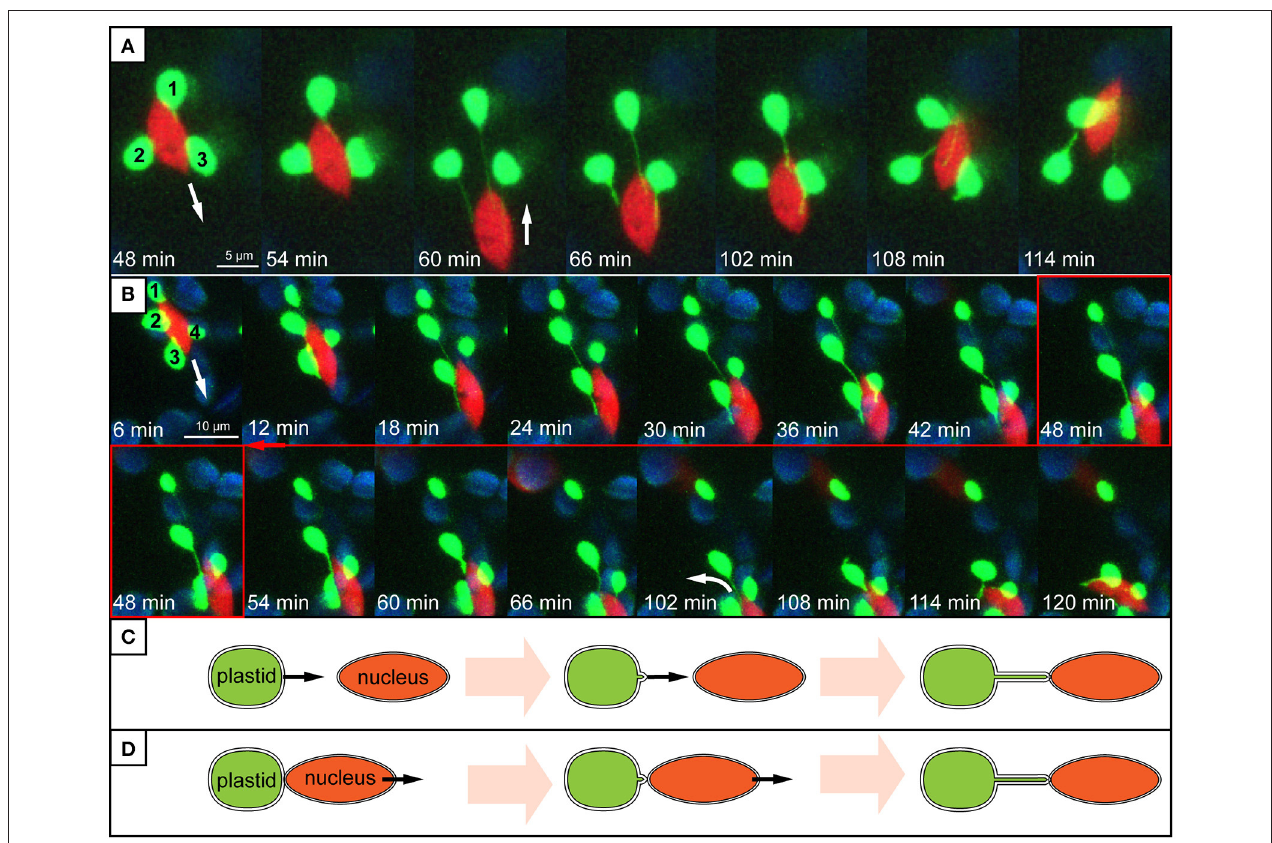
FIGURE 8 | Stromule behavior seems linked to nucleus movement. (A,B) Images are maximum intensity projections along the z-axis, taken from a time series of z-stacks obtained by a confocal laser-scanning microscope. Bright green plastids and red nuclei are organelles of the upper epidermis of an A. thaliana wild-type plant transformed with the pLSU4::pn plasmid (blue channel, chlorophyll fluorescence; red channel, H2B:mCherry fluorescence; green channel, FNRtp:eGFP fluorescence). The white arrows indicate the direction of nuclear movement. Larger, round, blue signals represent underlying mesophyll plastids, where chlorophyll signal is brighter than the FNRtp:eGFP fluorescence signal. (A) Series of images taken from Supplementary Movie 2. It demonstrates how nucleus movement “pulls” stromules out of a group of stationary plastids (1–3) and how stromules shorten, when the nucleus changes its direction. (B) Series of images from Supplementary Movie 3 showing how a nucleus moves away from a group of plastids (1–4). Plastids 2–4 keep their extended stromules and follow the moving nucleus. Plastid 1 stays stationary and looses its stromule after the nucleus moved more than 12 µ m away from it. (C,D) Schematic representation of two possible ways how nucleus associated stromules might be formed. (C) Scenario 1: stromules are formed by plastids residing further away from the nucleus growing toward (“reaching out”) and connecting to the nucleus. (D) Scenario 2: nucleus associated plastids are anchored to the surface of the nucleus and due to nucleus movement a stromule is pulled out of the surface of the stationary